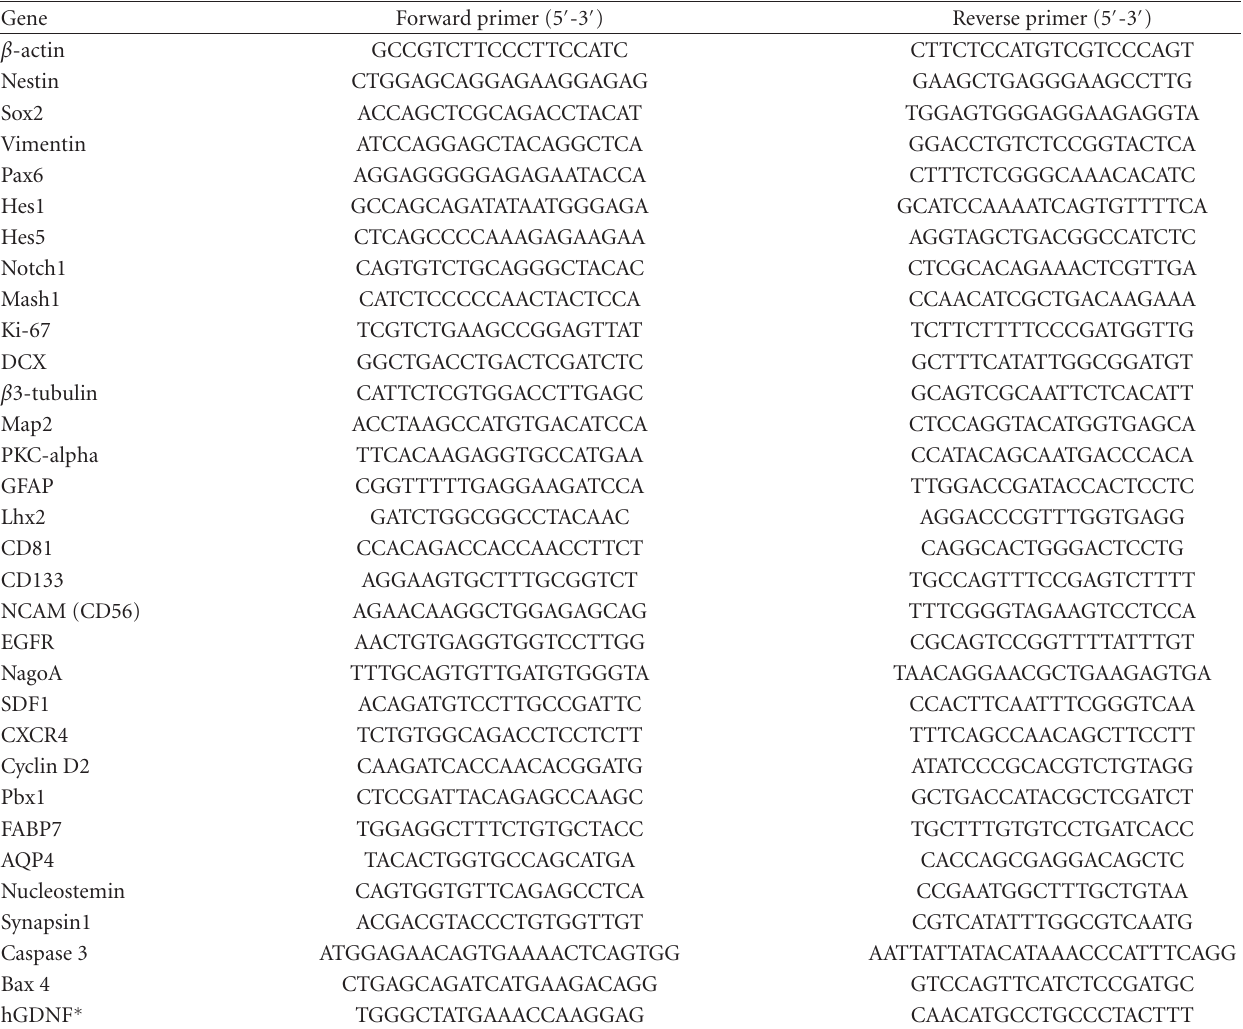
Table 1: Cat-specific primers for quantitative RT-PCR (GDNF =